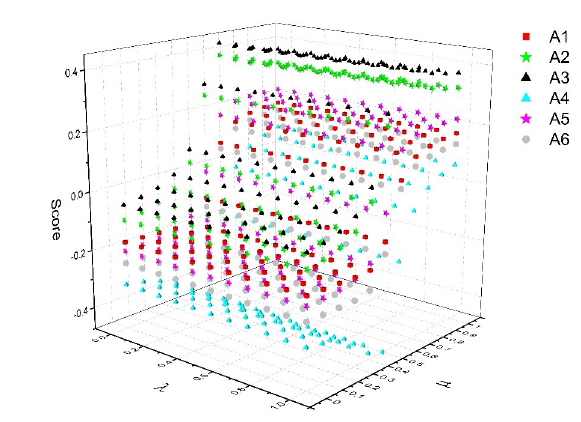
Figure 2. The final comprehensive score of each institution under the condition of two parameter values